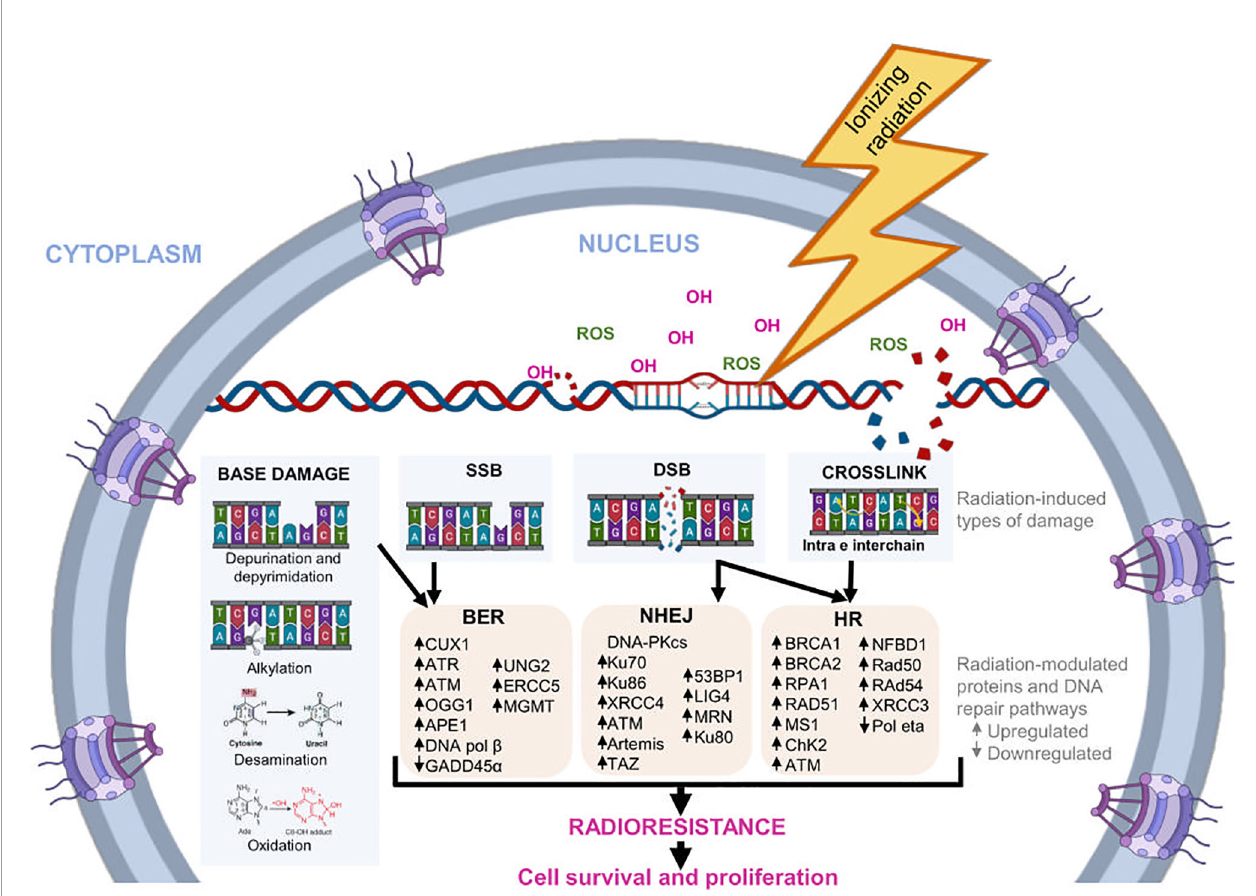
FIGURE 1 | DNA repair pathways induced by radiation. During radiotherapy, IR can alter the chemical structure of DNA directly or indirectly. Indirectly, it promotes the formation of molecules, such as the OH- ion and ROS, which bind to nucleotides and modify them structurally. The main modi fi cations induced by radiation are base damage, crosslink, SSB, and DSB. In response, cells regulate the expression of several genes and proteins involved in different DNA repair pathways, such as BER, NHEJ, and HR. The activation of this pathways helps to reduce radiation-induced DNA damage, favoring the survival and proliferation of tumor cells, as well as cellular